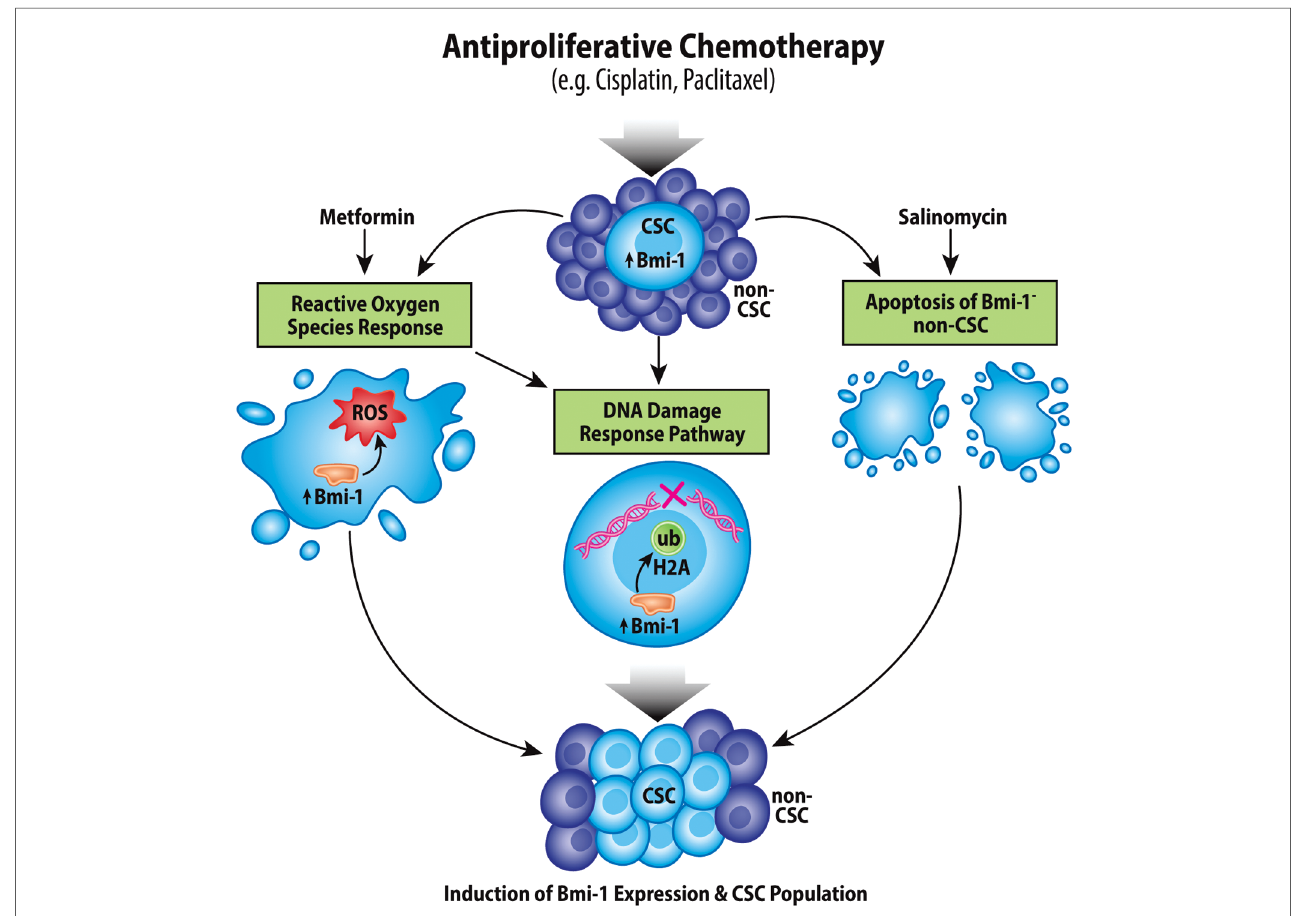
FIGURE 3 Chemotherapeutic induction of Bmi-1 increases the cancer stem cell population. Antiproliferative chemotherapeutic agents currently used for treatment of head and neck cancers have been shown to increase the CSC fraction in tumors via multiple mechanisms, which include inducing the reactive oxygen species response, the DNA damage response pathway, and apoptosis of Bmi-1 −